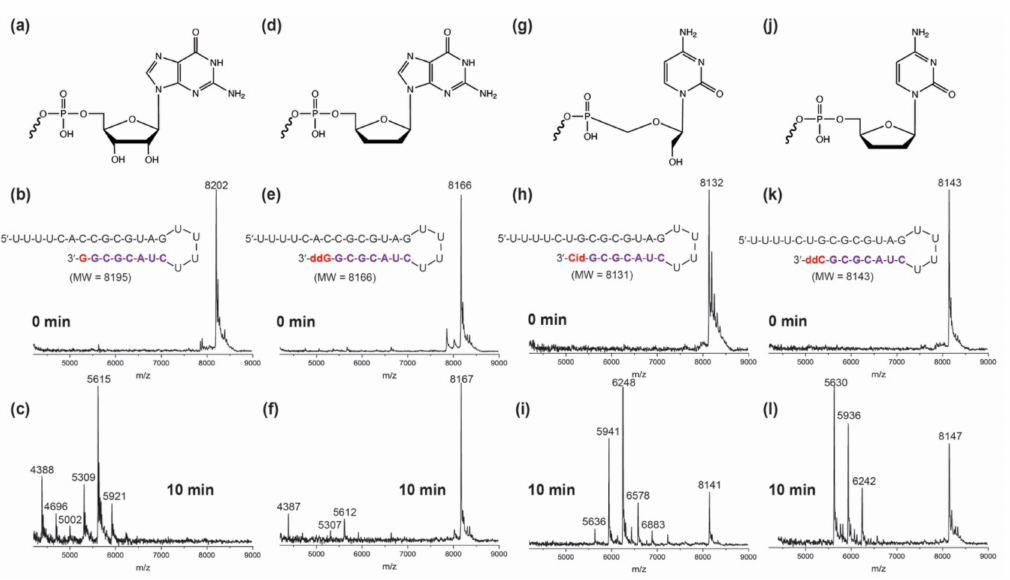
Figure 4. SARS-CoV-2 exonuclease activity with guanosine- or guanosine analogue-terminated RNA (a–f) and cytosine analogue-terminated RNA (g–l). A mixture of 500 nM of template-loop- primer terminated at its 3 (cid:48) end with either G ( a ), ddG ( d ), Cidofovir (Cid) ( g ) or ddC ( j ) (sequences shown in b , e , h , k ) and SARS-CoV-2 pre-assembled exonuclease complex (Nsp14/Nsp10) was incu- bated at 37 ◦ C for 10 min. These intact RNAs ( b , e , h , k ) and their respective exonuclease reaction products ( c , f , i , l ) were analyzed by MALDI-TOF MS. The signal intensity was normalized to the highest